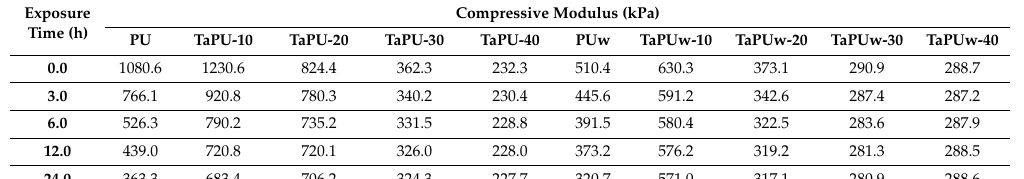
Table 4. Moduli of PU and TaPU foams at different UV exposure times.